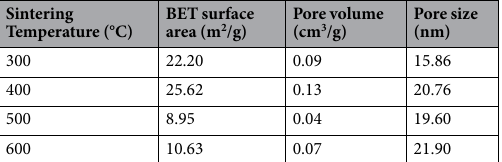
Table 2. Textural properties of MoO 3 prepared on different temperature.